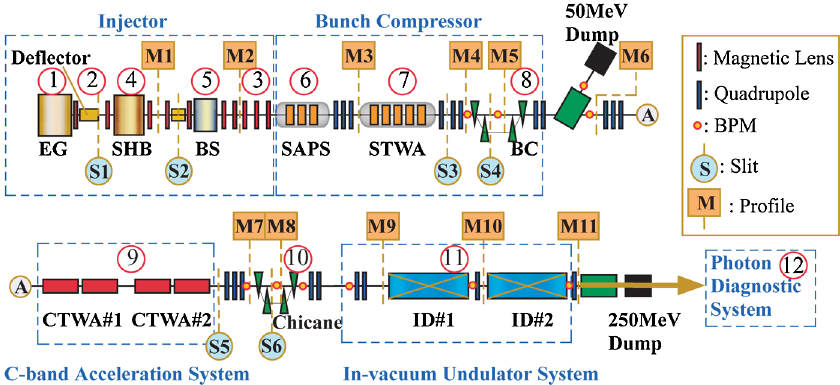
FIG. 1. (Color) Schematic representation of the SCSS test accelerator. 1, 500-kV electron gun (EG); 2, deflector with collimator; 3, a set of ten magnetic lenses; 4, 238-MHz subharmonic buncher (SHB); 5, 476-MHz booster cavity (BS); 6, S-band APS cavity (SAPS); 7, S-band traveling-wave acceleration structure (STWA); 8, bunch compressor (BC); 9, C-band acceleration system (CTWA#1&CTWA#2); 10, chicane; 11, in-vacuum undulator system (ID#1&ID#2); and 12, photon diagnostic